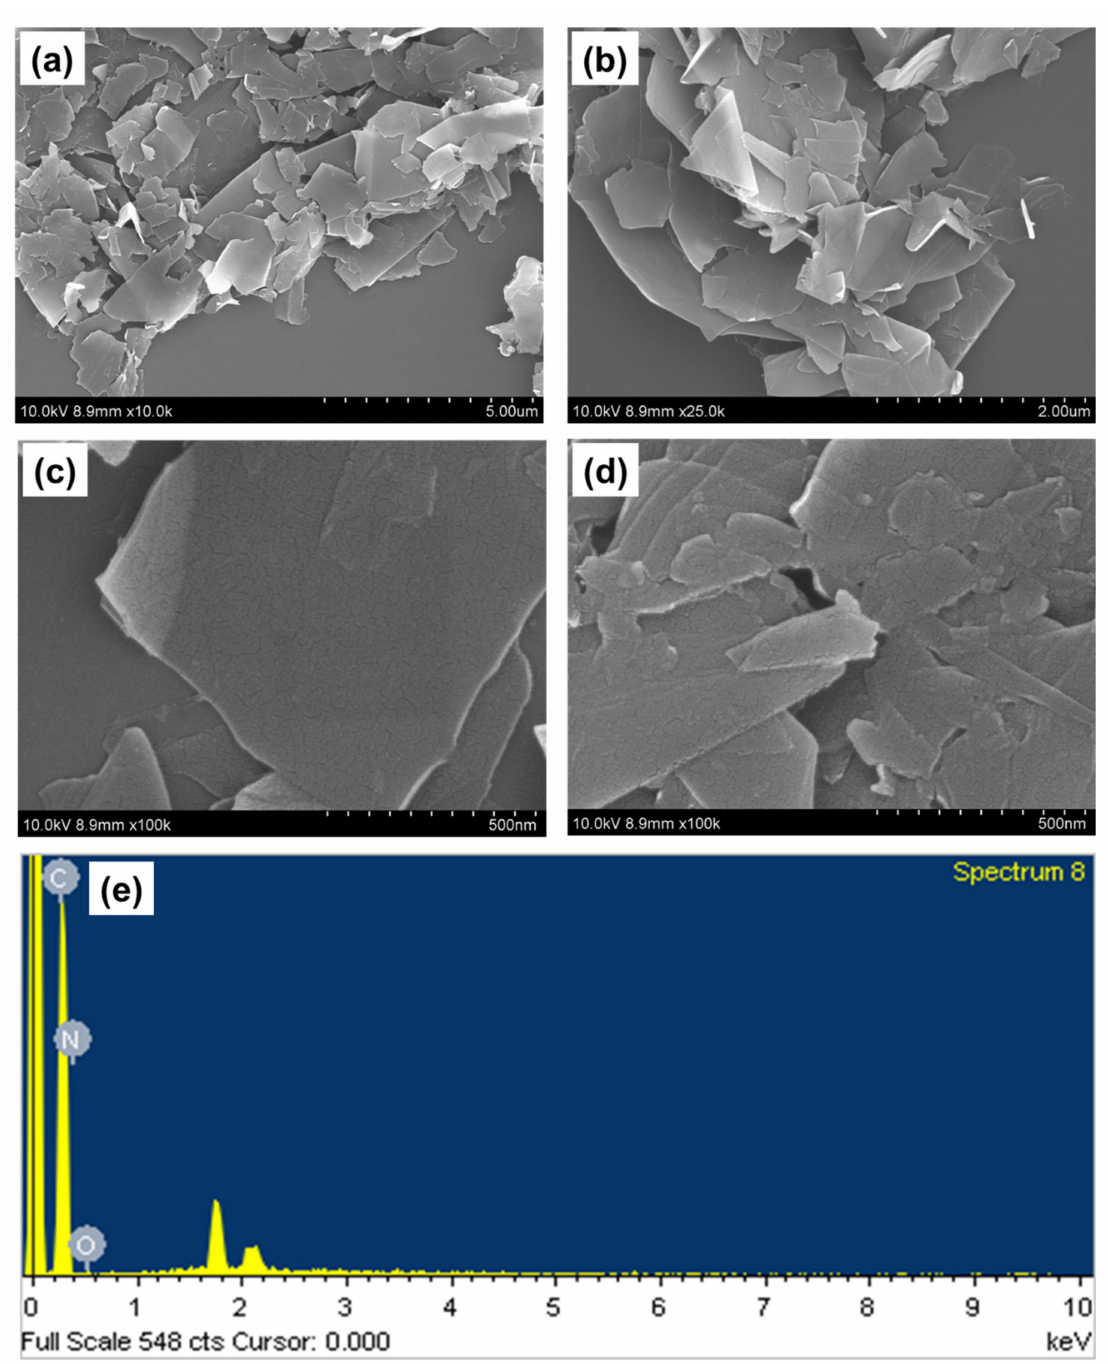
Figure 1. ( a – d ) FESEM images of graphene/poly- N -vinyl pyrrolidone (GPNVP) composite at different magnifications. ( e ) EDS spectrum of GPNVP